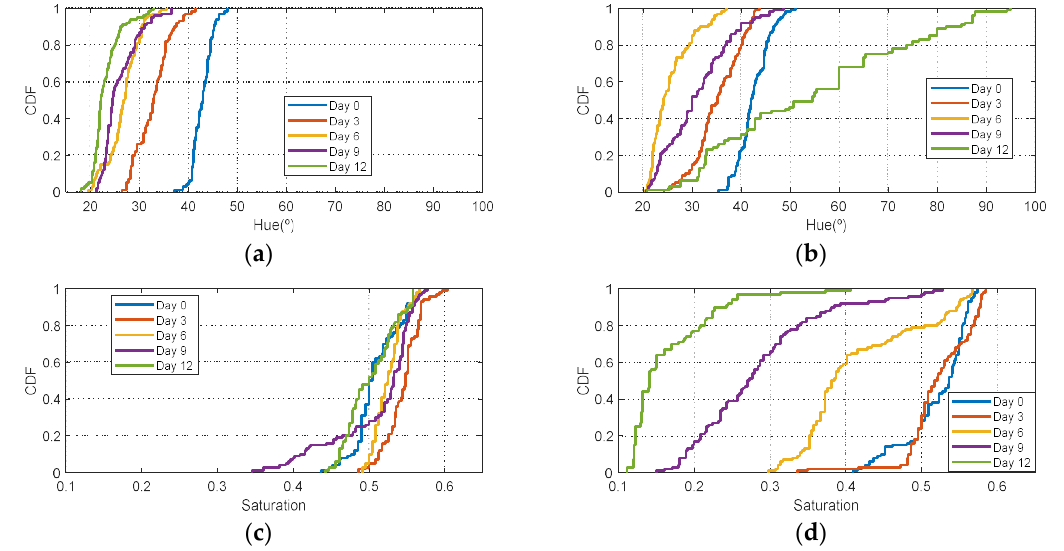
Figure 9. Cumulative Distribution Function (CDF) of the hue parameter for the banana in the fridge ( a ) and at room temperature ( b ) as a function of the number of days. Cumulative Distribution Function (CDF) of the saturation parameter for the banana in the fridge ( c ) and at room temperature ( d ) as a function of the number of days.